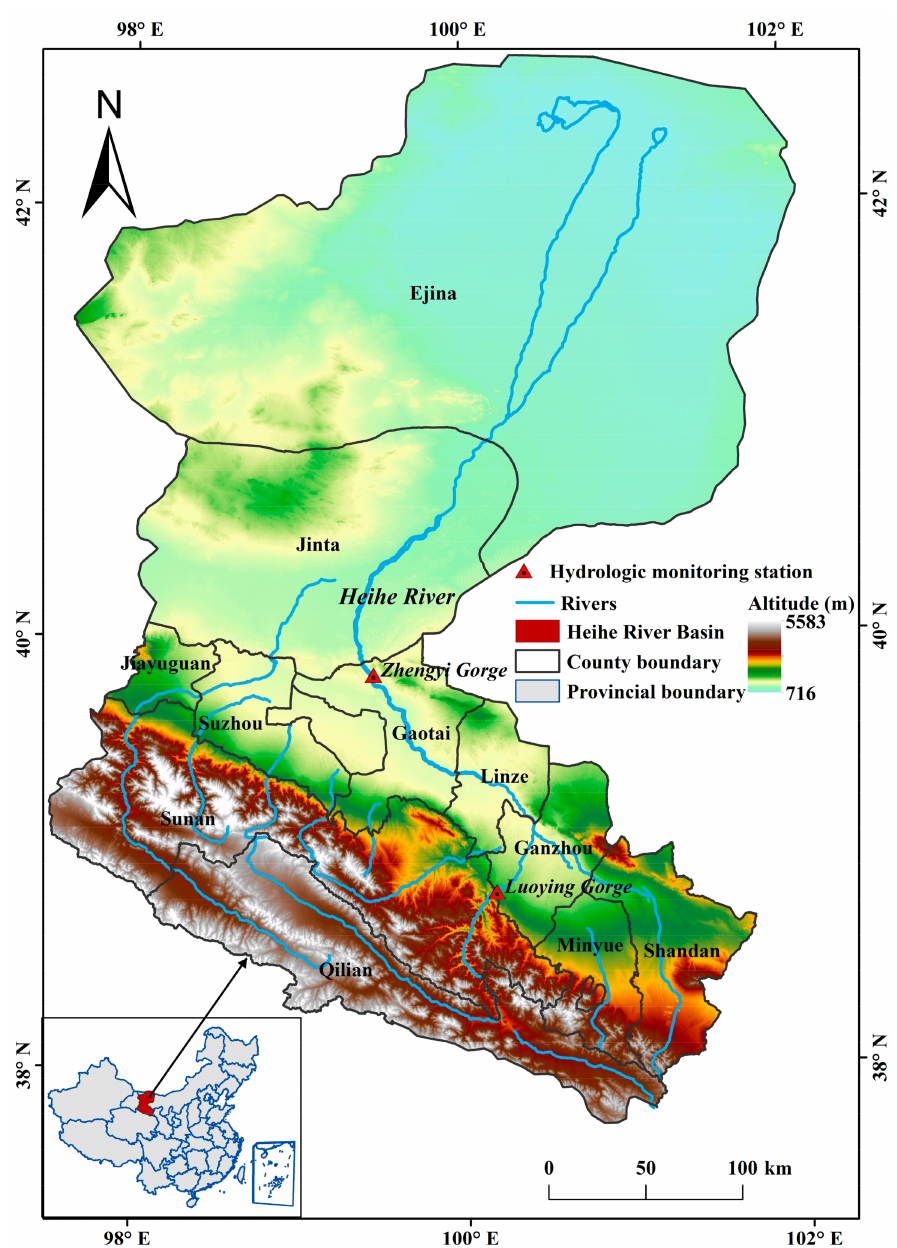
Figure 1. Map to show the geographical location and administrative divisions of the